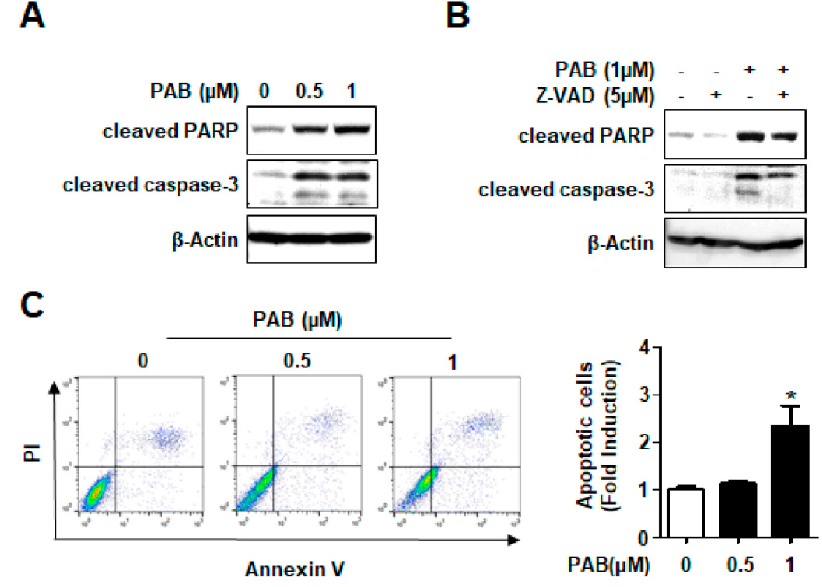
Figure 2. Effects of PAB on caspase-dependent apoptosis in HN22 cell line. ( A ) Western blotting using the antibodies against cleaved PARP and cleaved caspase-3 was performed. Actin was used as a loading control. ( B ) HN22 cells were pre-treated with 5 µ M Z-VAD (a pan-caspase inhibitor) for 1hr prior to PAB. Protein level of cleaved PARP and cleaved caspase-3 were analyzed by western blotting. ( C ) Fluorescence-activated cell sorting (FACS) analysis of annexin V / propidium iodide (PI)